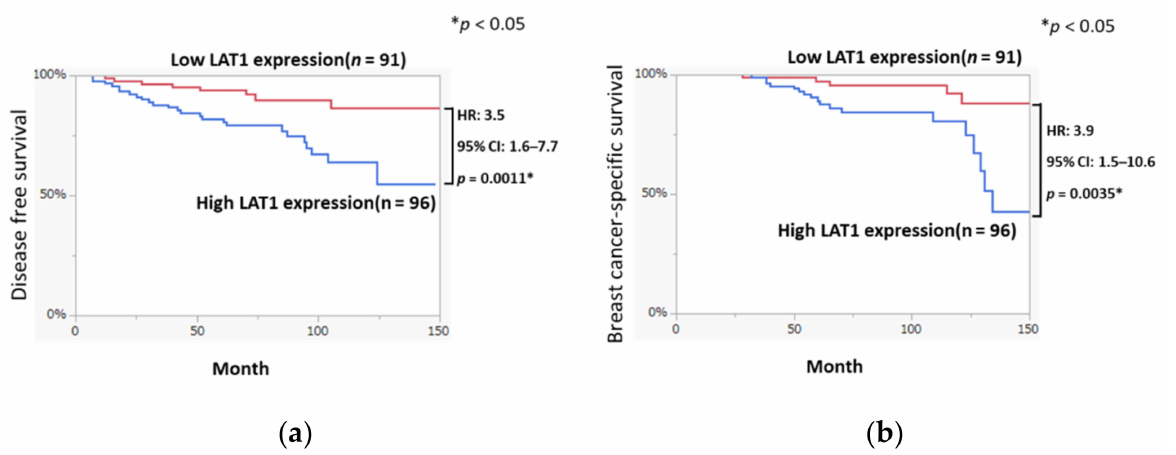
Figure 1. Postoperative survival of ER-positive breast cancer patients classified by LAT1 expression. Cause-specific postoperative survival curves ( a ) disease-free survival [DFS] and ( b ) breast-cancer-specific survival [BCSS] for patients with high and low LAT1 expression levels were demonstrated. The data was analyzed by the Kaplan-Meier method and the log-rank test. * p <